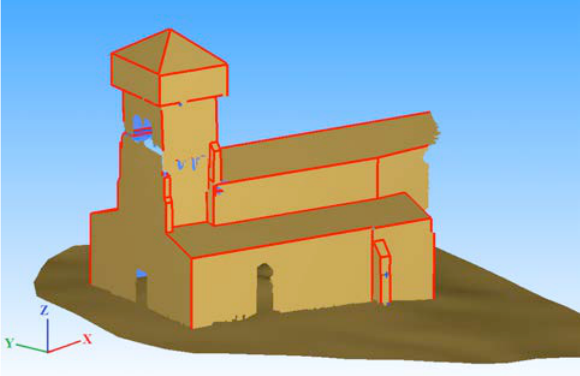
Figure 11. Meshed model obtained with 3D Reshaper